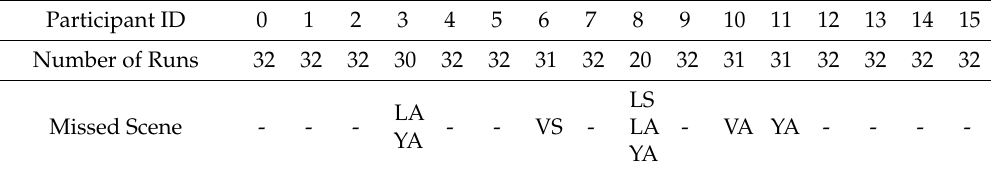
Table 3. The number of threshold detections out of 32 and missed